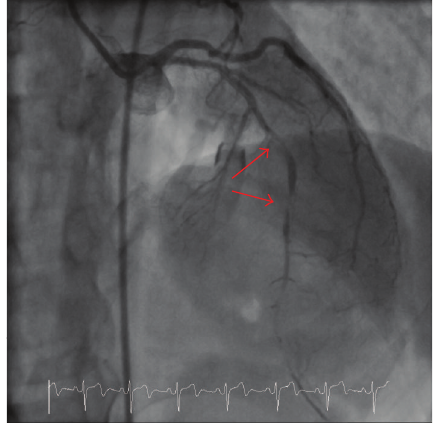
Figure 2: Initial coronary angiography showing two high grade lesions in series in the left anterior descending artery.